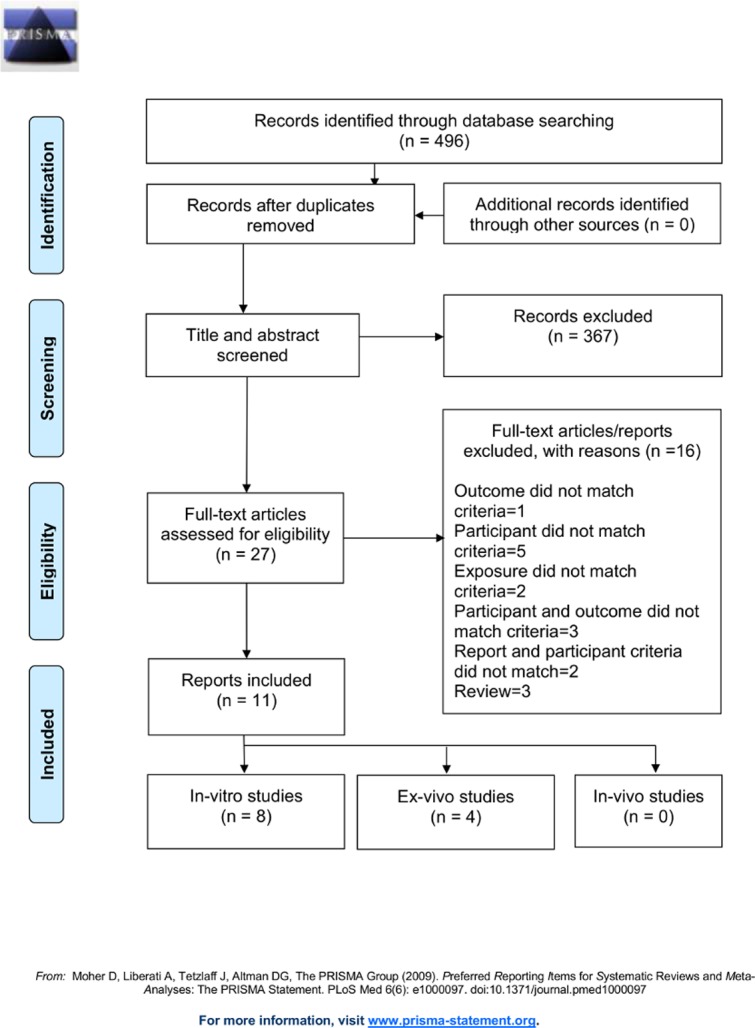
PRISMA flow chart.